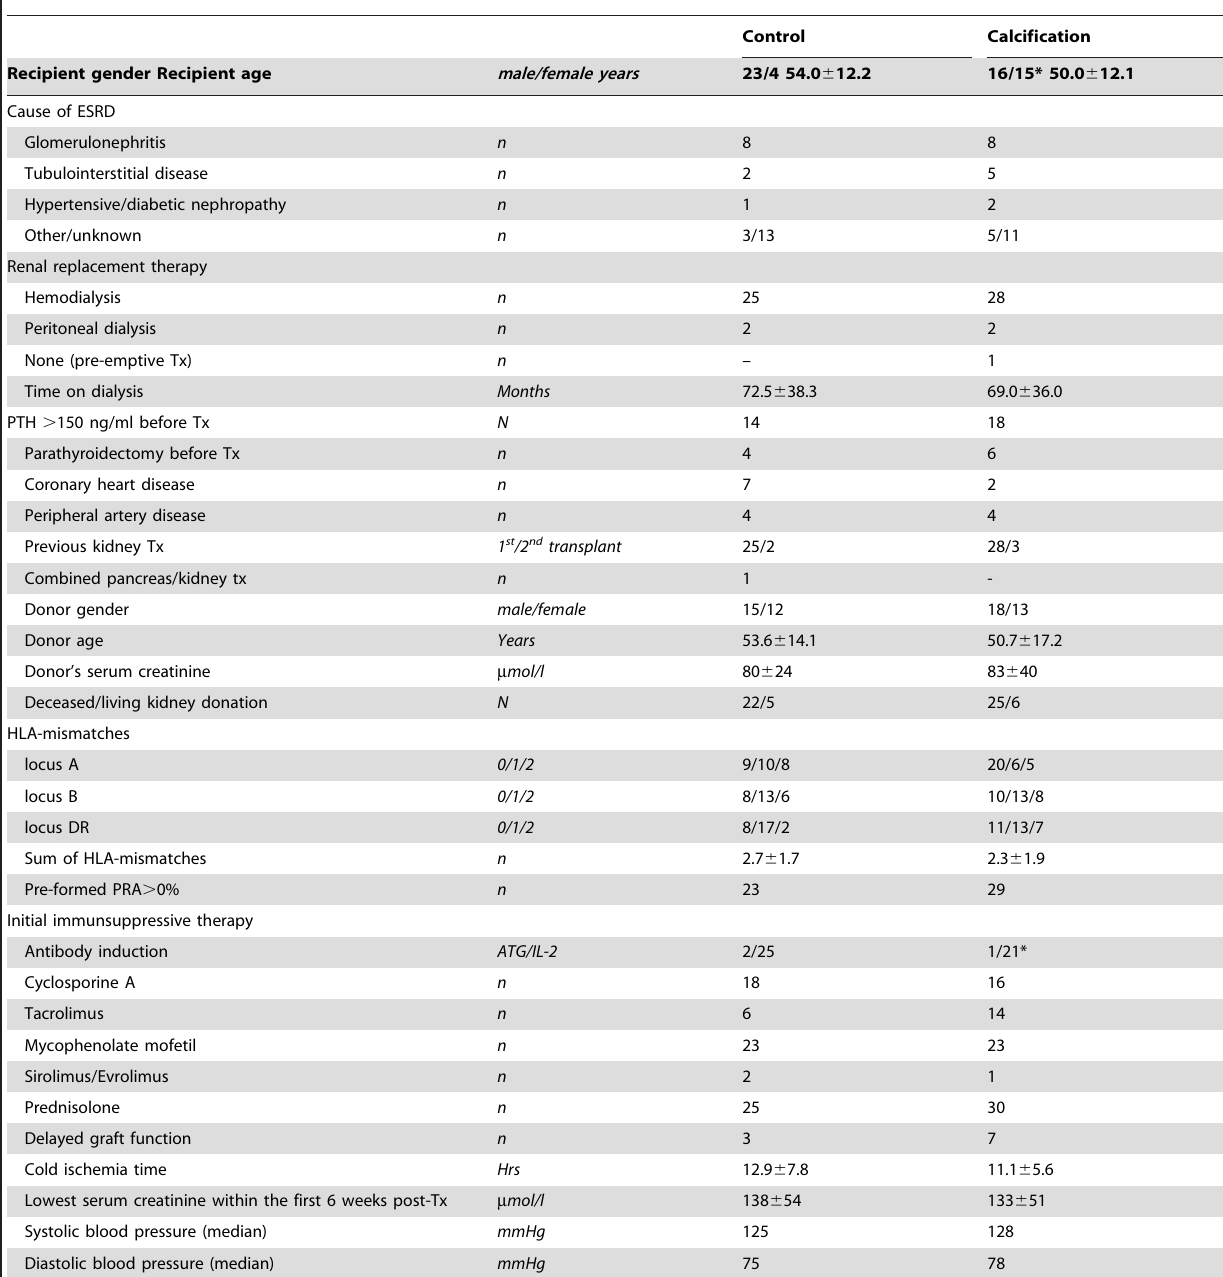
Table 1. Demographics and transplant data of patients with and without (controls)